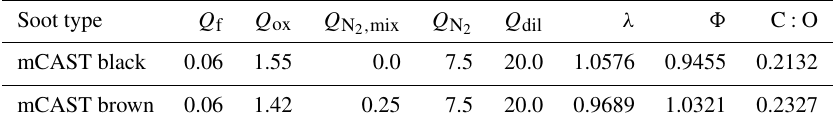
Table B1. Summary of the settings for miniCAST Series 4200, used to produce mCAST black and mCAST brown presented in this study. Q f denotes the volumetric C 3 H 8 (fuel) flow c , Q ox the oxidation air a flow, Q N N 2b and Q dil the dilution air a flow. All flows are given in units of standard ( Lmin − 1 ) . λ , (cid:56) and C : O indicate the air–fuel equivalence ratio, the fuel–air ratio and the atomic carbon:oxygen ratio, respectively, as described in the